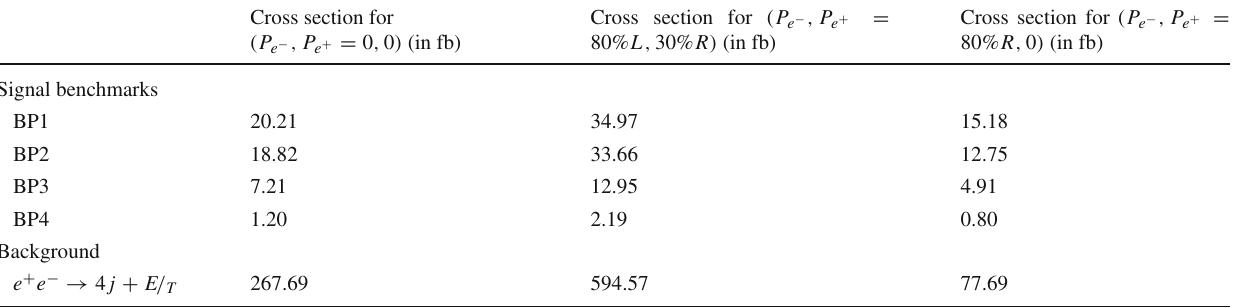
Table 15 The effective cross-sections of the signal and background for 4 j + E / T channel at LO at 1 TeV ILC using unpolarised and polarised incoming beams Cross section for Cross section for ( P e − , P e + = ( P e − , P e + = 0 , 0 ) (in fb) 80% L , 30% R ) (in